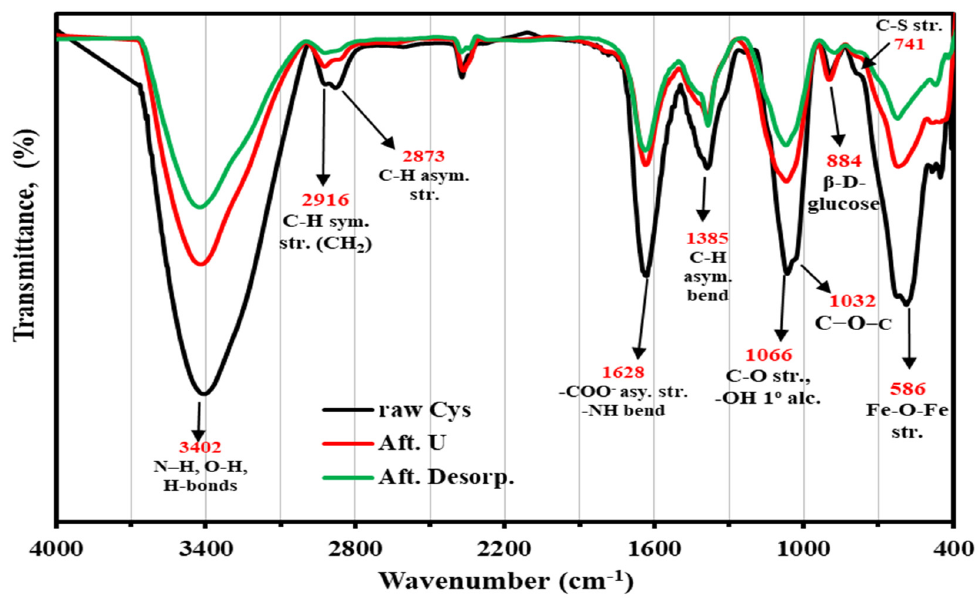
Figure 3. FTIR spectra of the Cys sorbent before and after uranium loading, and at the end of the sixth sorption/desorption cycle.